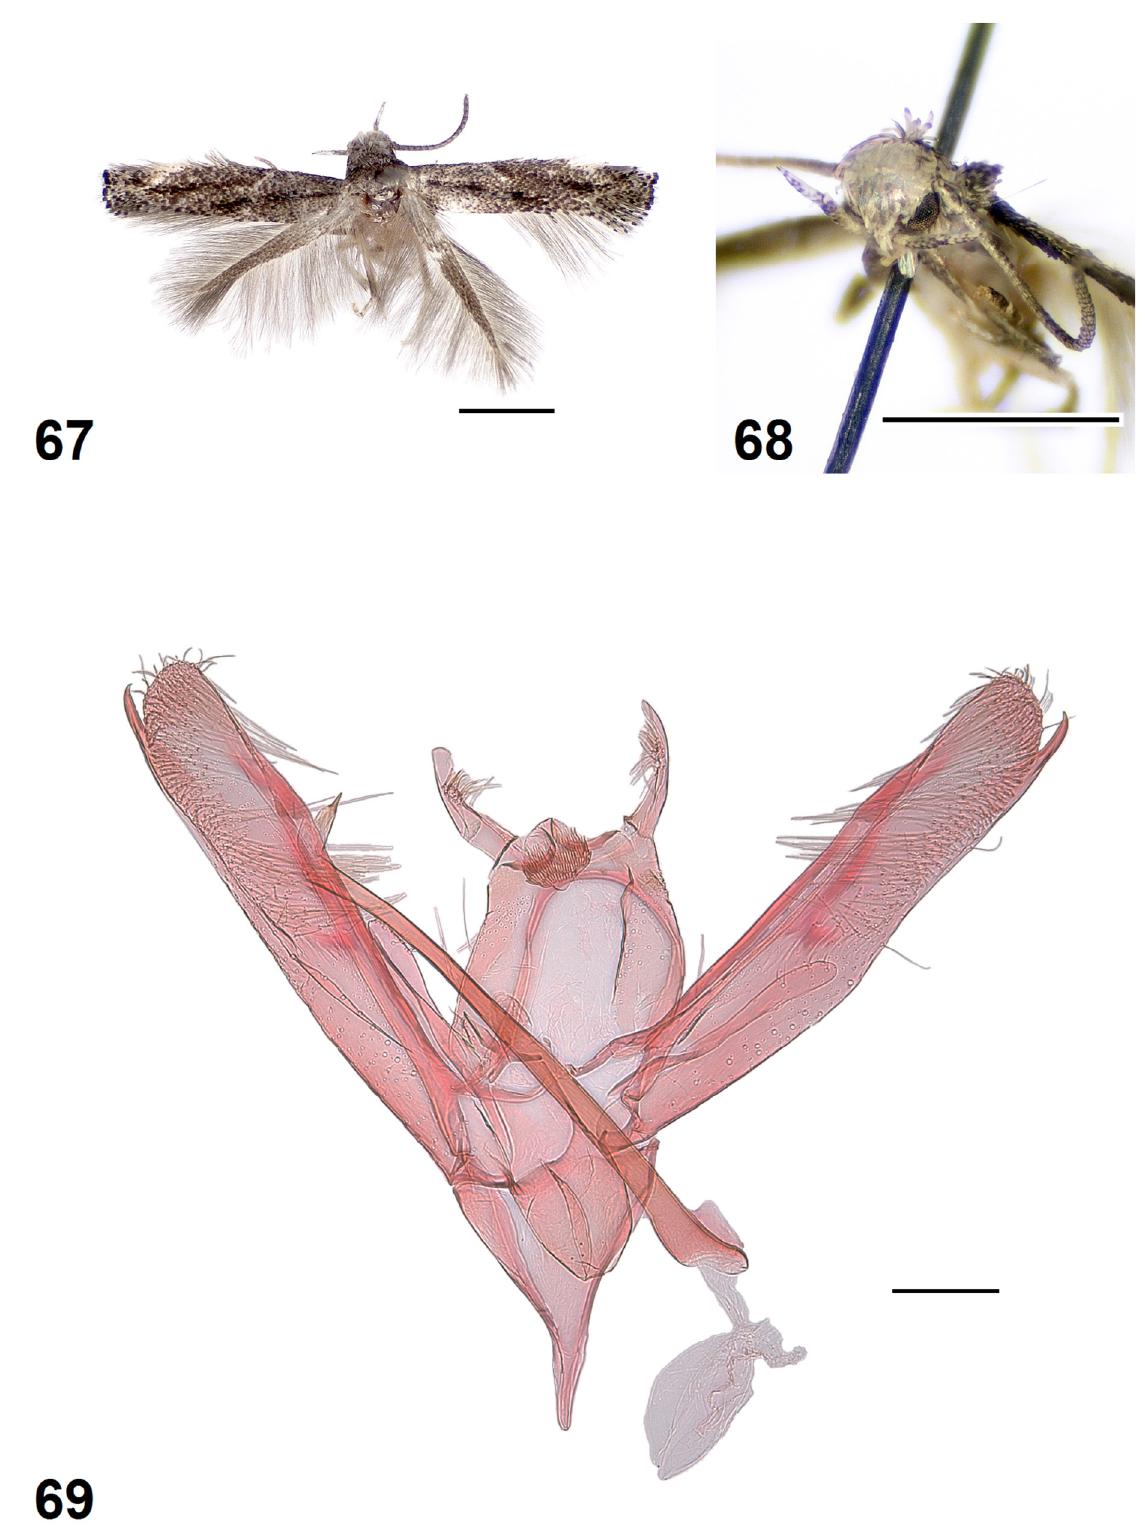
Figs 67–69. Elachista siamensis Sruoga & Kaila sp. nov., holotype, ♂ (ZMUC 2070). 67 . Adult. 68 . Head, latero-frontal view. 69 . General view of male genitalia. Scale bars: 67–68 = 1 mm; 69 = 0.1